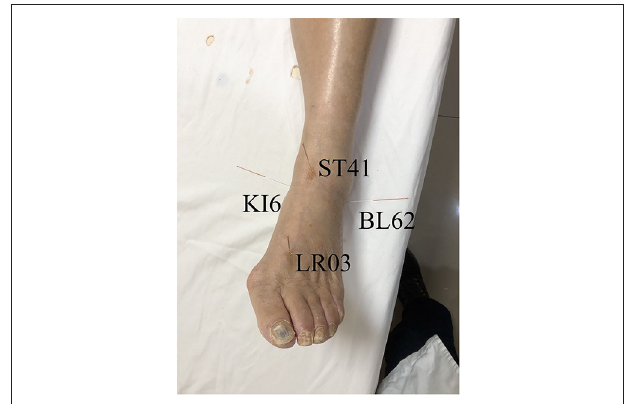
FIGURE 2 | The selected acupoints Shenmai (BL62), Jiexi (ST41), Zhaohai (KI6) and Taichong (LR03) on the left side.